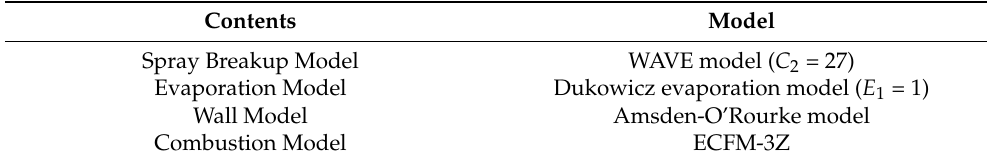
Table 2. The selected simulation model.